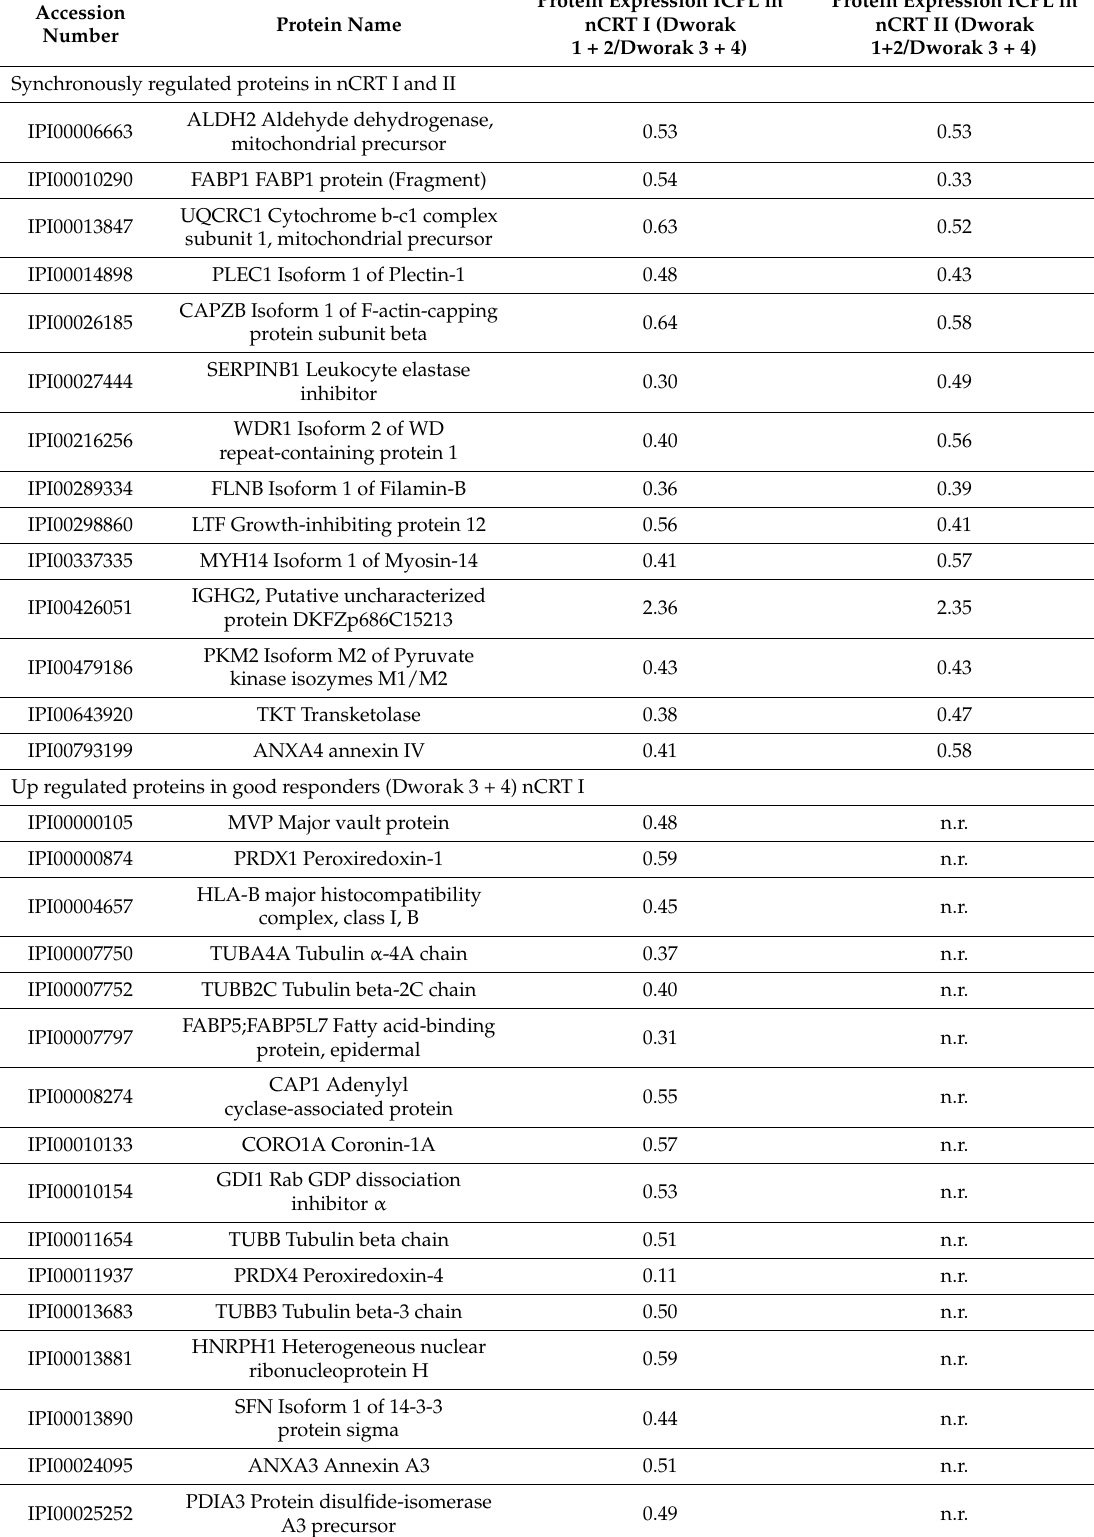
Table 1. Differentially regulated proteins identified by isotope coded protein label (isotope coded protein label (ICPL)) between poor (Dworak 1 + 2) and good (Dworak 3 + 4) responders to neoadjuvant chemoradiation (nCRT) I or II; n.r.: not regulated regarding the selection criteria (regulation